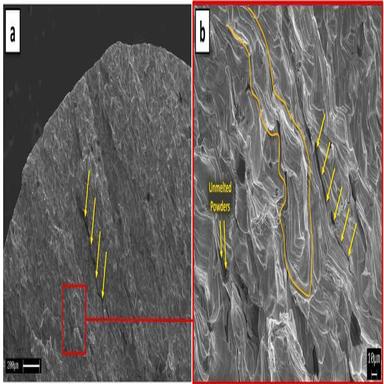
SEM images of "AM.m.H" specimen fracture surface; intergranular fracture displaying at two magnification.